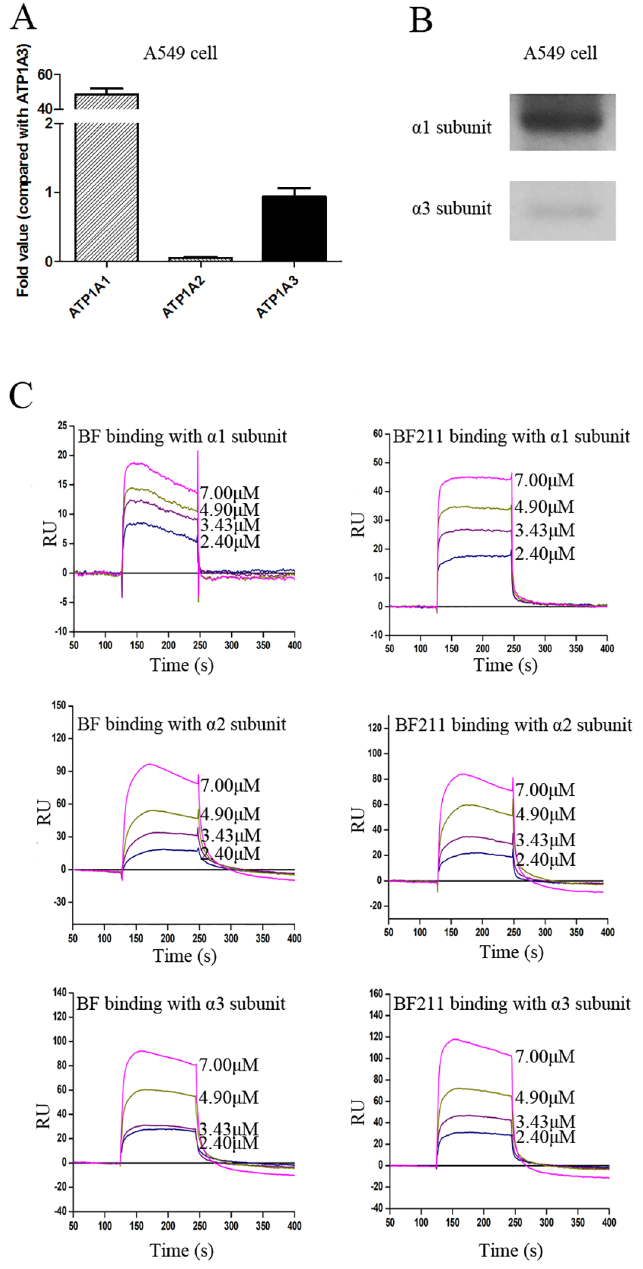
Fig 3. Expression of Na+/K+-ATPase α subunits in A549 cells and binding affinity of BF or BF211 to Na+/K+-ATPase α subunits. (A) The results of the RT-PCR analysis of the expression levels of the α subunits of Na+/K+-ATPase in A549 cells. The data comprise the statistical results (n = 3, mean ± SEM) of three independent experiments. (B) The representative results of the western blot assay probing the protein levels of the α 1 and α 3 subunits of Na+/K+-ATPase in A549 cells. (C) The real time binding affinity measurements of BF or BF211 to the recombinant Na+/K+-ATPase α subunits. The binding ability between the compound and the recombinant protein is reflected in recorded response unit (RU)